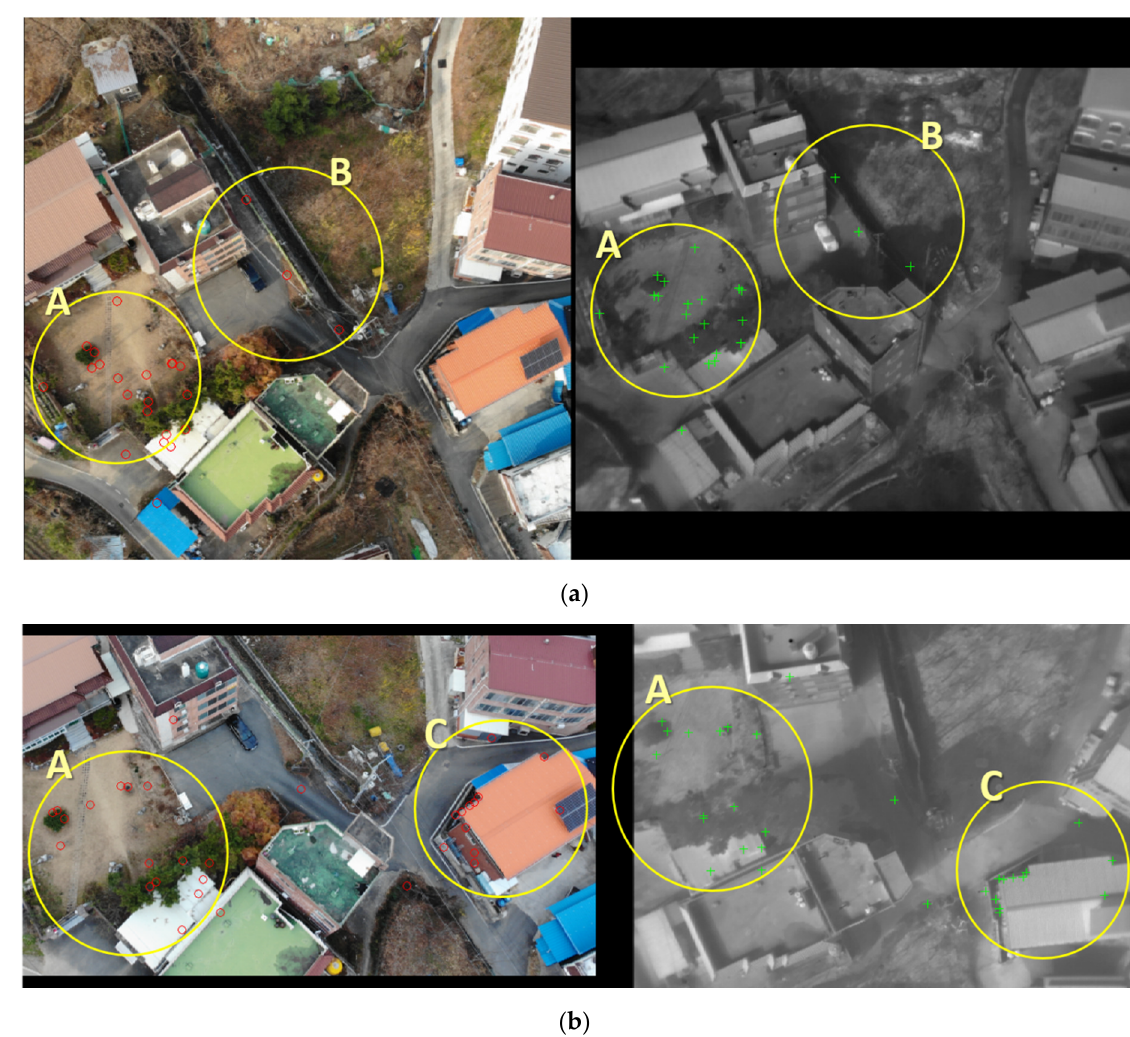
Figure 9. Understanding the characteristics of feature points of the building type: ( a ) visible nadir-looking vs. TIR oblique case; ( b ) visible oblique vs. TIR nadir-looking case.